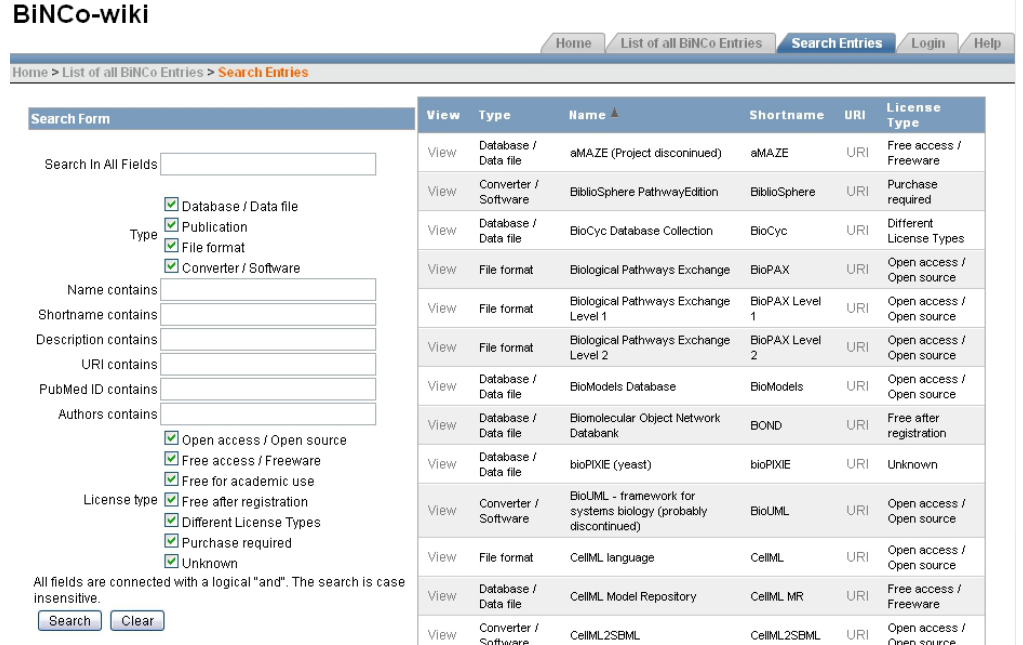
Figure 5: Search entries of BiNCo-wiki. On the left side the search form and on the right side the results are shown. The initial setting shows all